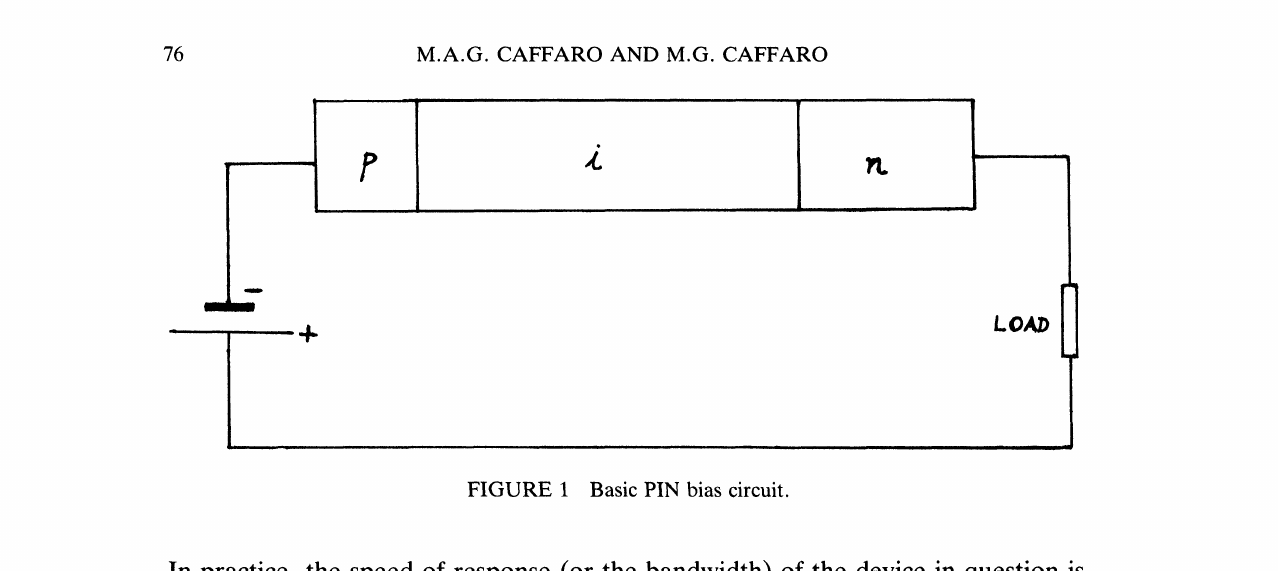
FIGURE 1 Basic PIN bias